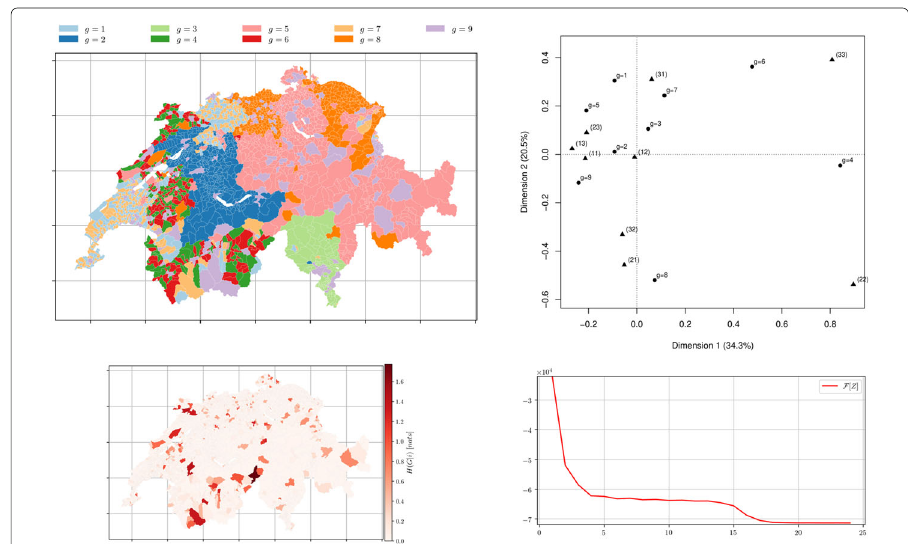
Fig. 9 Municipalitiessoftclusteringonallthetopics depicts the semi-supervised hard assignment obtained from a random membership Z 0 for m = 9 groups using distance matrix D obtained from topic modelling with k = 9 after 24 iterations. Lefttop Hard membership. Leftbottom the conditional entropy of topics H ( R | i ) showing municipality-topic probability distribution uncertainty. Righttop the CA bi-plot between Z ∞ ( • ) and the official classification ( (cid:2) ) with m = 9. Rightbottom The free-energy plot ( β = 20, α = 10)